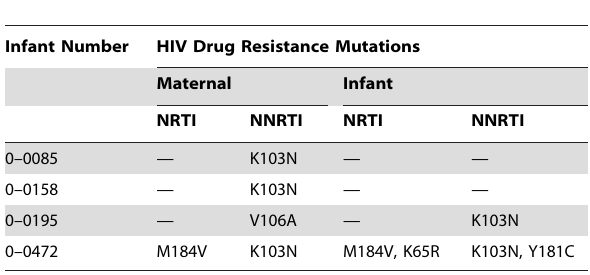
Table 4. Comparison of infant and maternal HIV drug resistance mutation patterns by 6